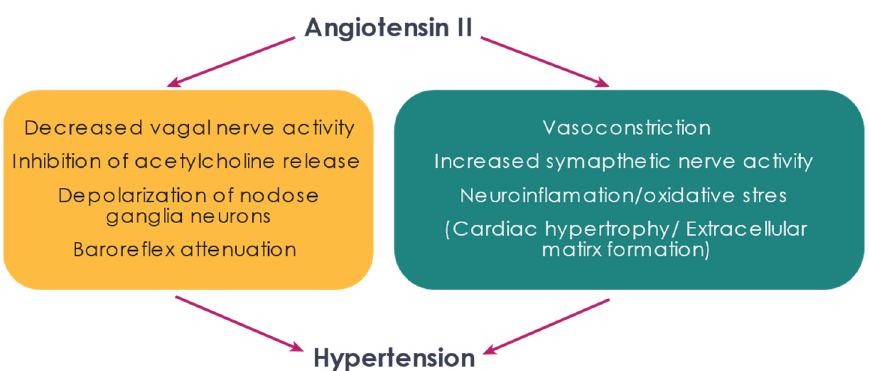
Figure 3. Ang II contributes to the generation of hypertension through actions on vasculature and the autonomic nervous system. Targeting these pathways may be therapeutically beneficial in the treatment of hypertension.